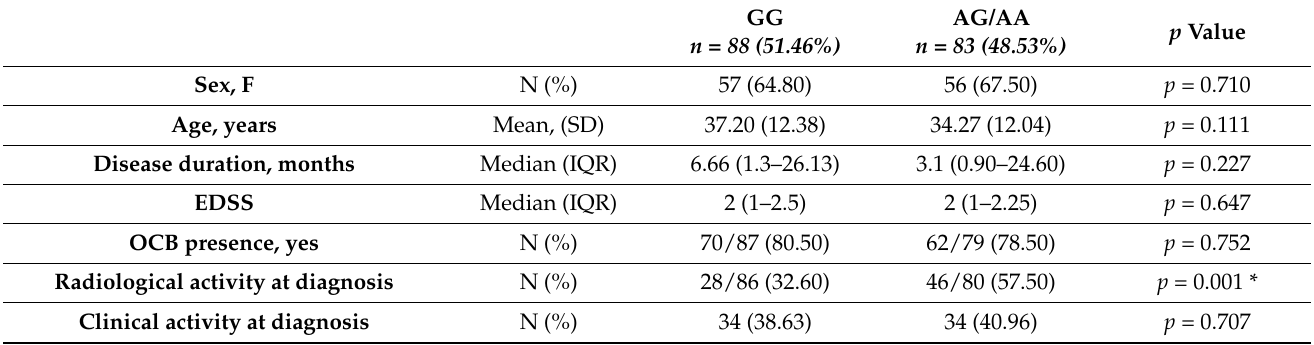
Table legend: Subjects carrying homozygous major allele of SNP (GG), subjects carrying A minor allele (AG/AA) for SNP rs18188792 . (*) denotes statistical significance ( p < 0.05) using a nonparametric Mann–Whitney test for continuous variables and a chi-square test for categorial variables. Abbreviations: multiple sclerosis (MS), relapsing remitting (RR), expanded disability status scale (EDSS), interquartile range